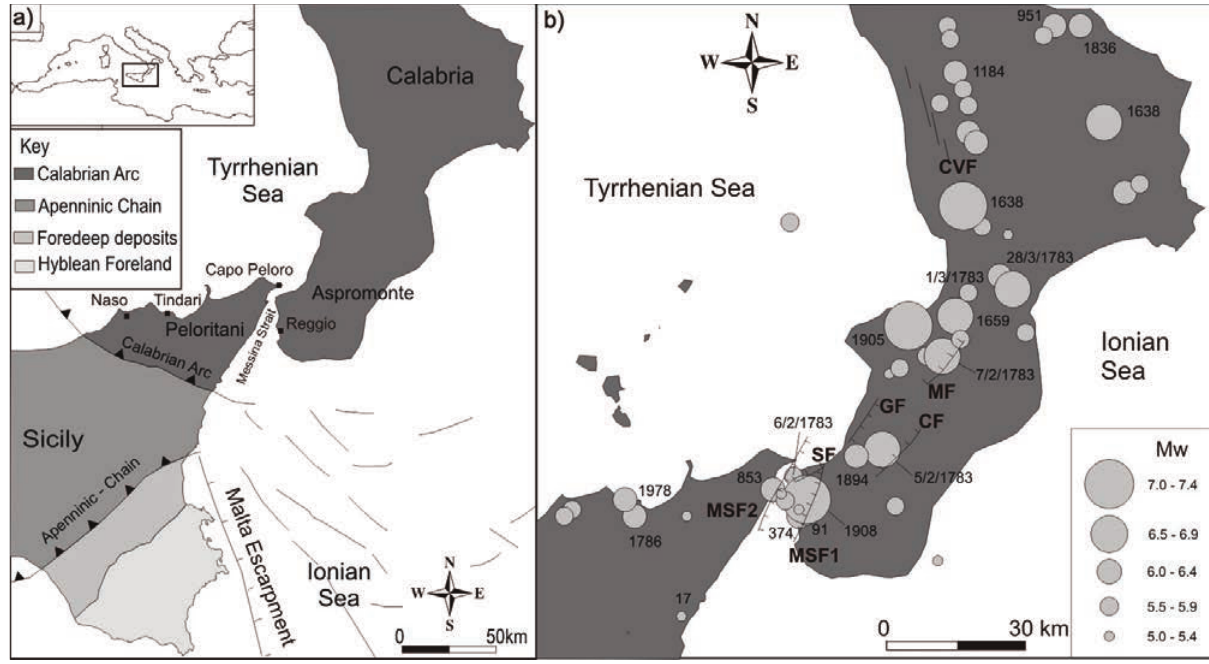
Figure 1. a) Geological sketch map of southern Calabria and north-eastern Sicily Apennine-Maghrebian Orogenic system; and (b) main his- torical earthquakes: epicentres (filled circles) from the CPTI4 catalogue [CPTI Working group 2004]. The faults associated with the most dis- astrous earthquakes are also shown: CVF= Crati Valley Fault; MF=Mesima Fault; CF=Cittanova Fault [Jacques et al. 2001, Galli and Bosi 2002], GF=Gioia Fault [DISS Working Group 2010], SF=Scilla Fault [Jacques et al. 2001, Ferranti et al. 2008], MSF1=west dipping Messina Strait Fault [Monaco and Tortorici 2000], MSF2=east dipping Messina Strait Fault [Pino et al. 2000, Basili et al. 2008, DISS Working Group 2010].